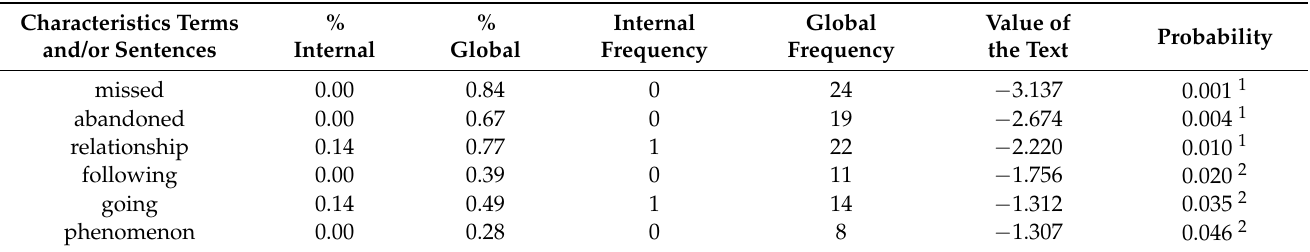
Table 8. The words significantly less used by the teachers in answering to the question: “How the school could reduce school